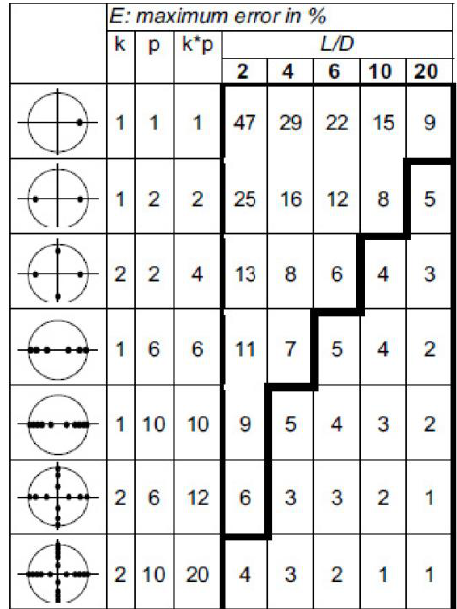
Table 3. Relative maximum error for various configurations of measuring points and distance from the source of the flow distortion